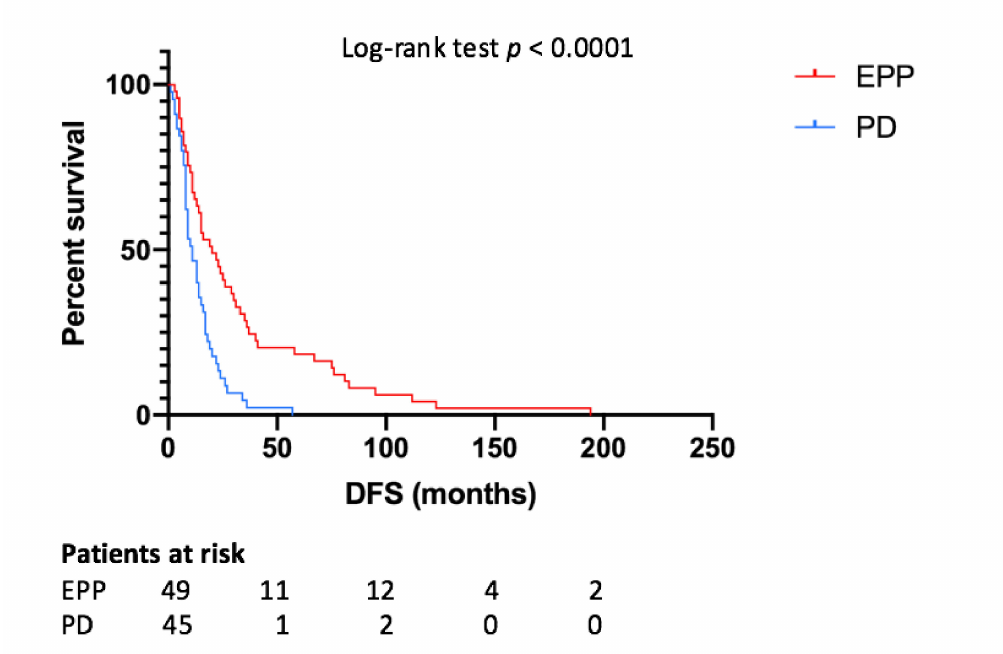
Figure 3. Disease-free survival depending on type of surgery. EPP—extrapleural pneumonectomy; PD—pleurectomy/ decortication; DFS—disease-free survival.